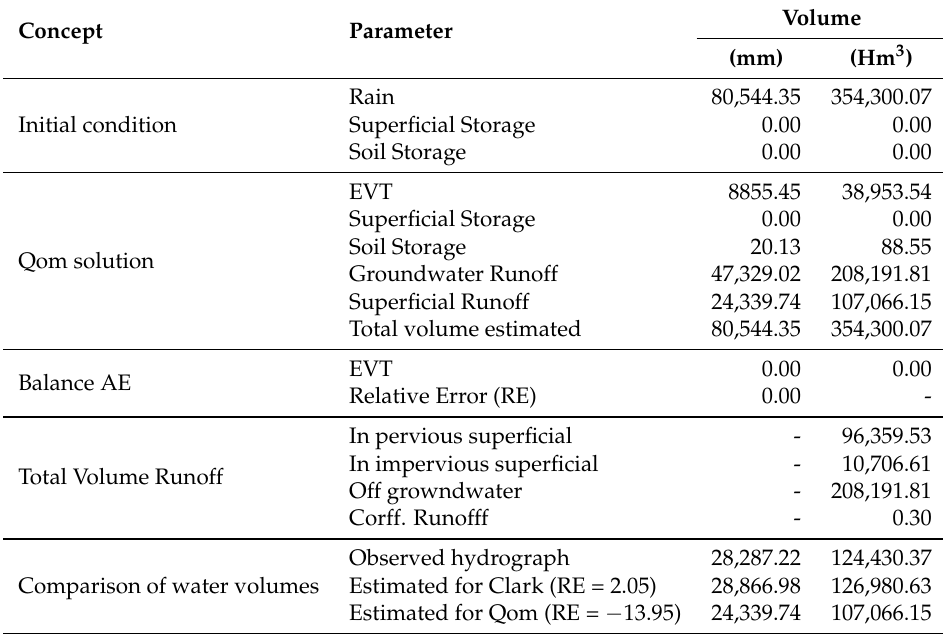
Table 4. Hydrologic results for instance 6.2CV (Cuenca del Alta del Rio Bermejo, Argentina), Qom-Clark